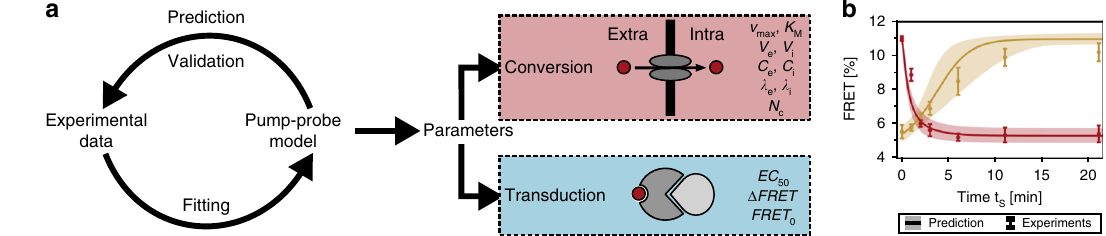
Fig. 6 PhrA signal processing is well described by the pump – probe model. a Experimental – theoretical work fl ow. Experimental data were fi tted to the pump – probe model to infer the parameters that determine extra- to intracellular signal conversion and transduction of the signal into a FRET output. The inferred parameters were then used to make testable predictions and validate the model experimentally. See lines in Figs. 4 and 5 for best fi ts using parameters in Table 1. b Model validation: model-based predictions with 95% con fi dence intervals (lines and shaded area) and experimental results for a stimulation experiment with 30 nM PhrA. The response dynamics to stimulation (red) is shown, together with the depletion of PhrA from the supernatants as measured by the bioassay (black). Data: mean ± SD from n e = 3. Source data are provided as a Source Data fi le.